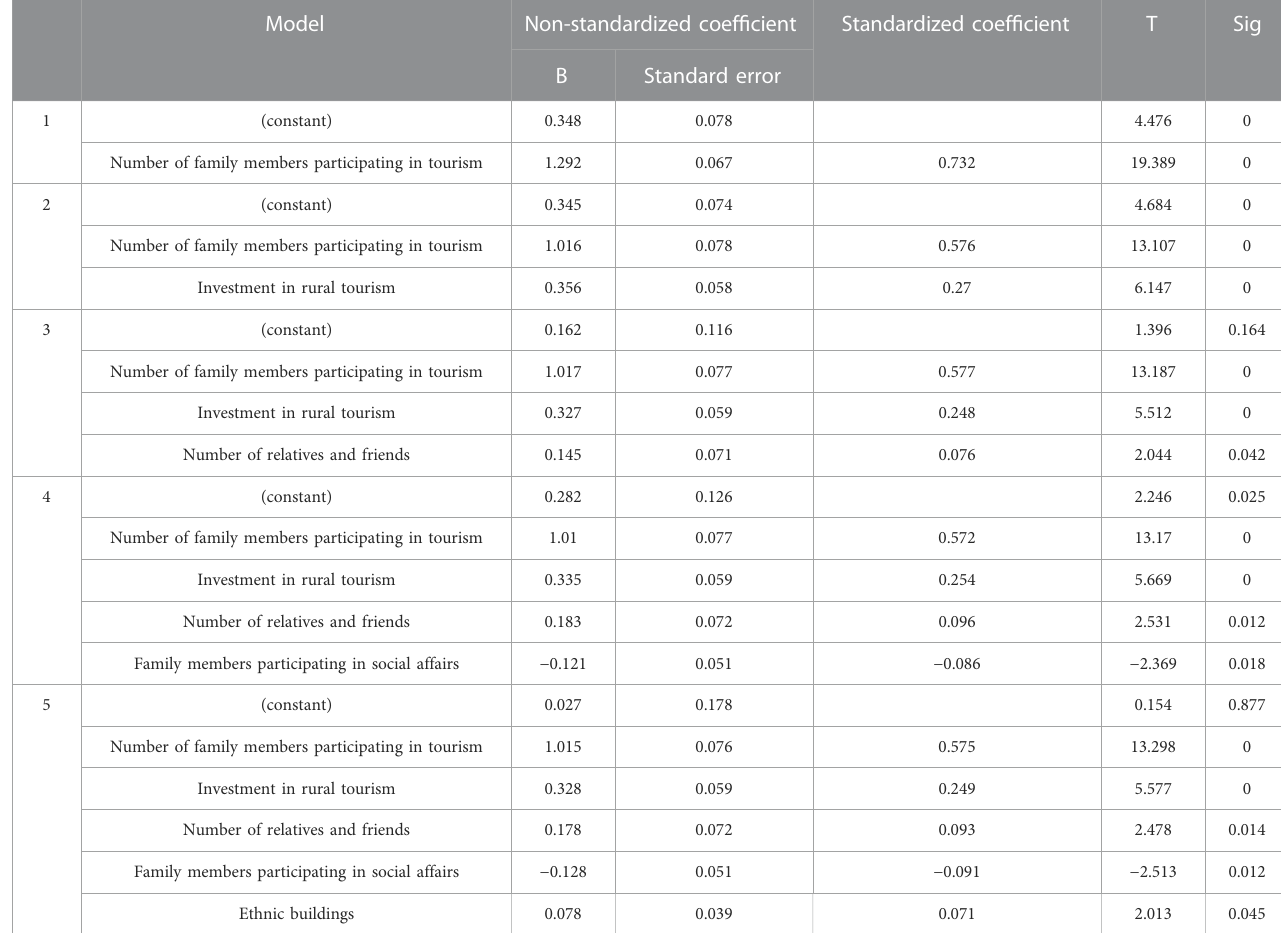
TABLE 6 Statistics in each step of the regression